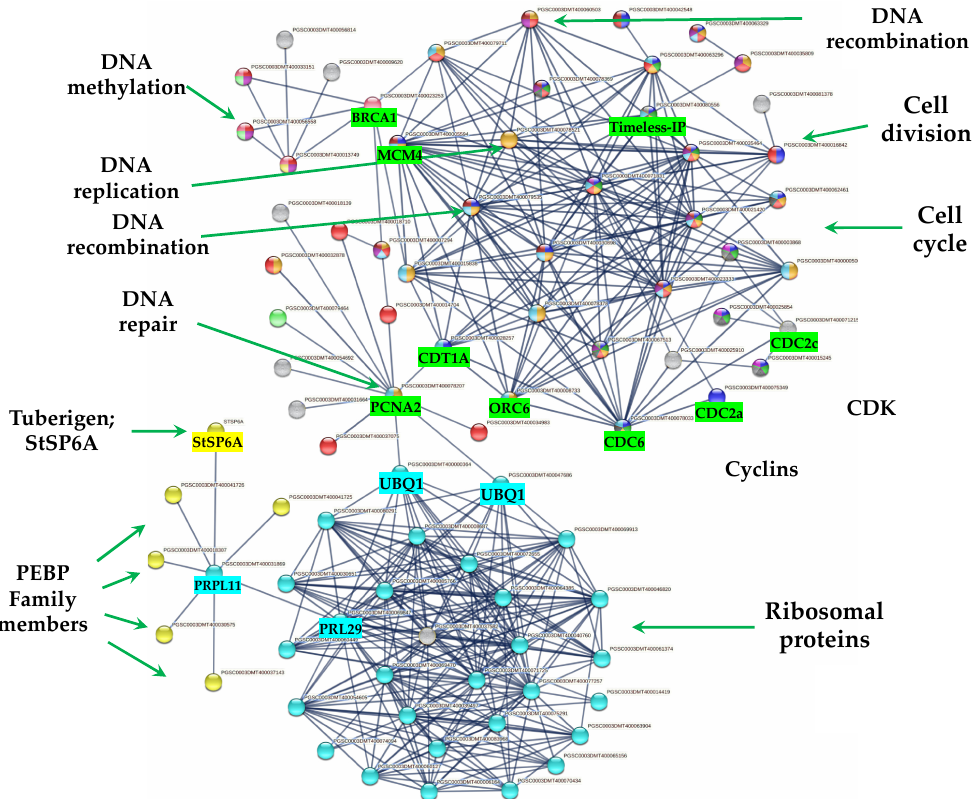
Figure 11. PPI physical network of up-regulated transcripts genes of potato S. tuberosum from the transcriptomic-wide analysis with high confidence (0.860). Selected proteins are highlighted with the name of the gene.